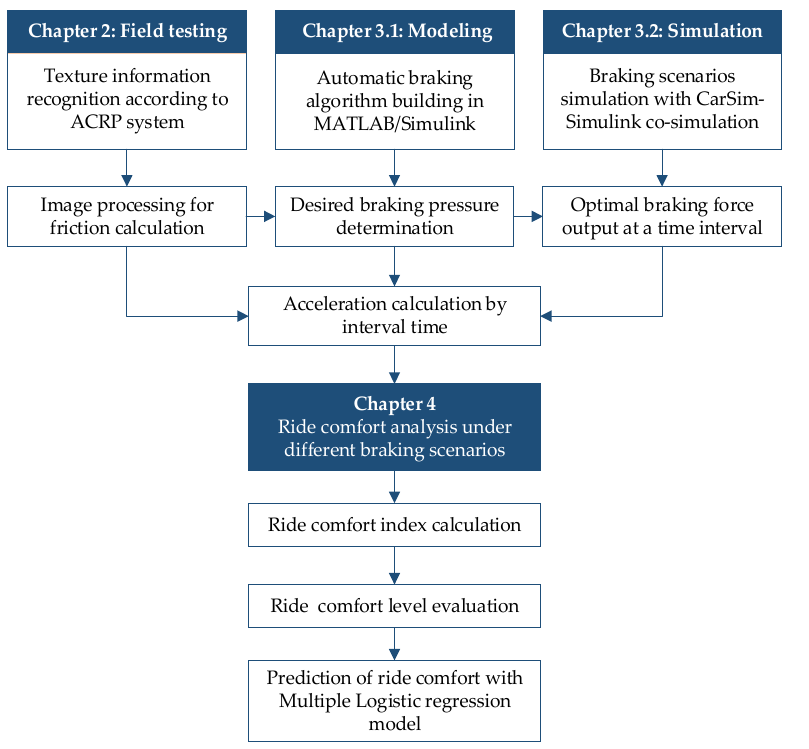
Figure 1. Research framework of this study.